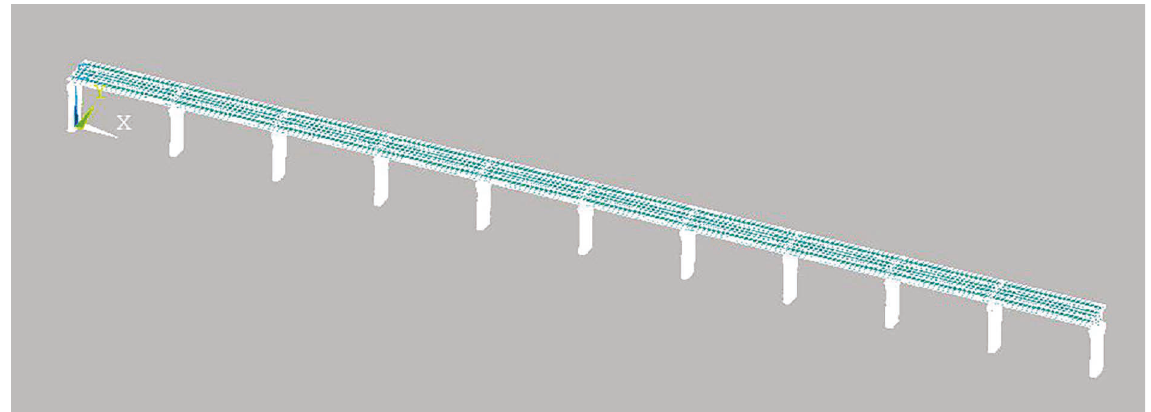
Figure 5: Bridge model.